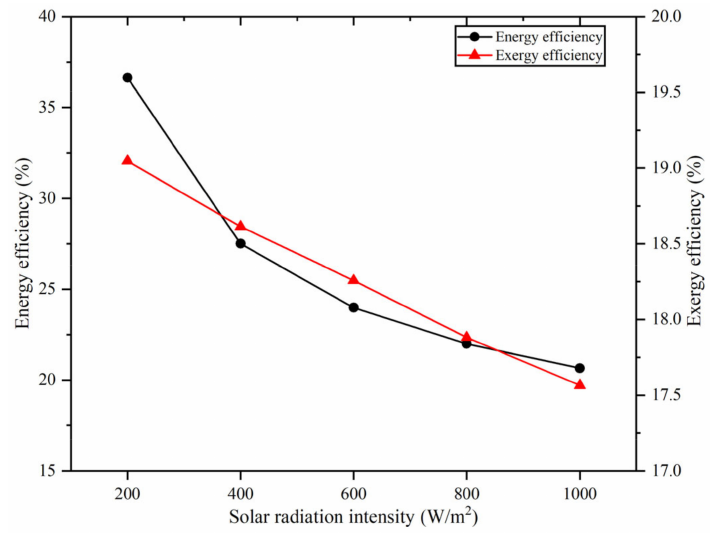
Figure 20. System exergy efficiency with different solar radiation intensity. (2)